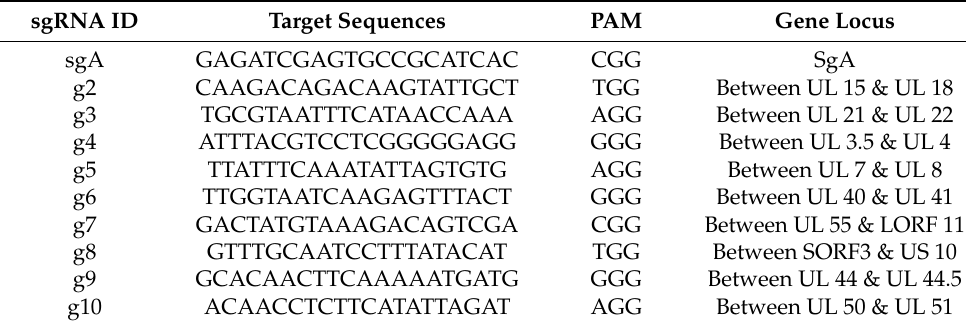
Table 1. The sgRNA lists and target sequences in DEV * for generation recombinant virus. sgRNA ID Target